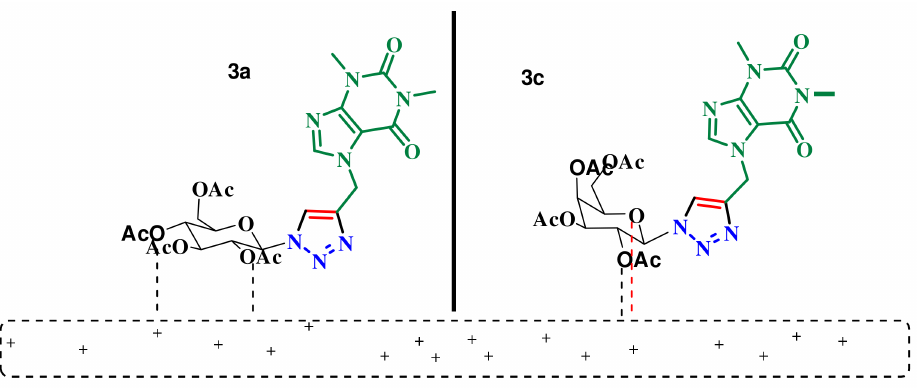
Figure 9. Comparison of inhibitor adsorption by compound 3a and 3c in metal surface.